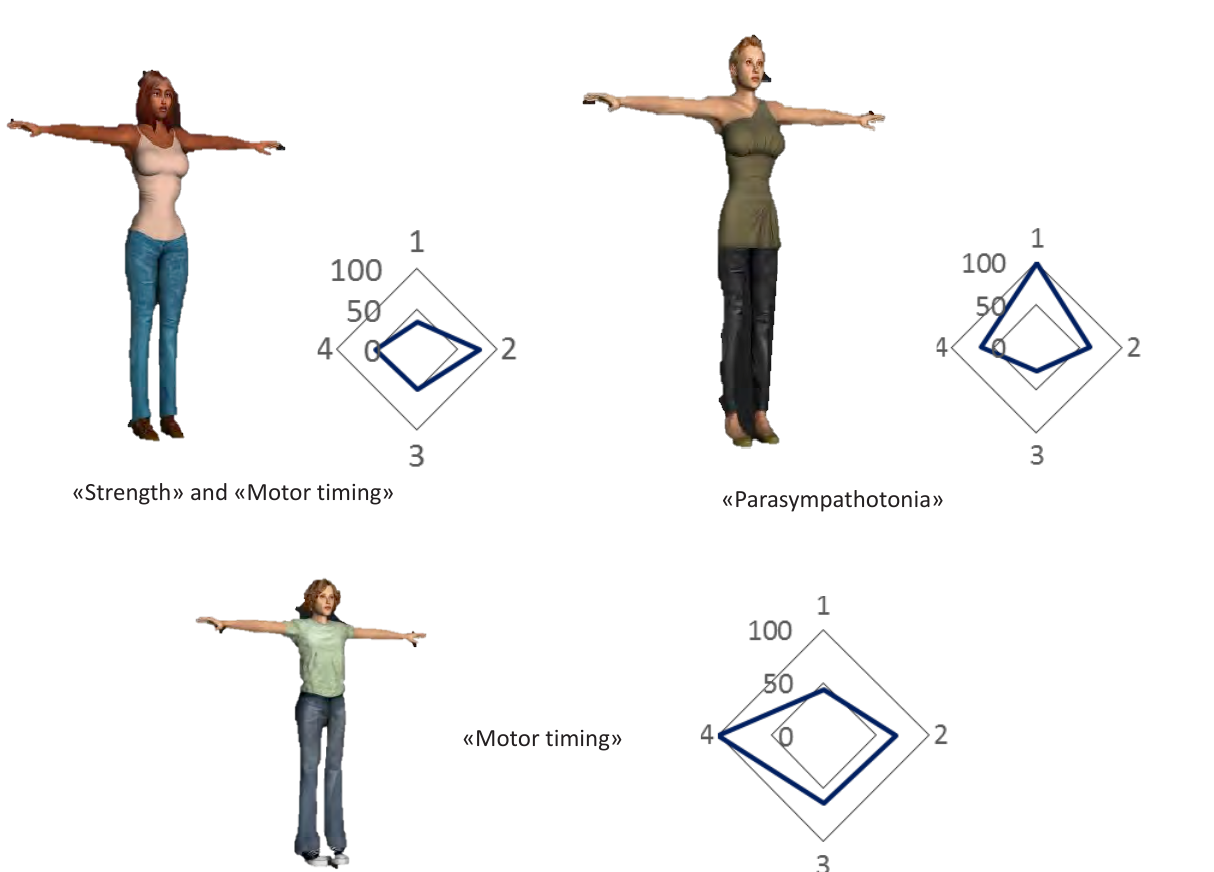
Fig. 3. The examples of individual factorial structure of functional and psycho-physiological opportunities at athletes: results of mathematical and visual 3D-modeling: 1 – Factor «Parasympathicotonia»; 2 – Factor «Strength»; 3 – Factor «Mobility of a nervous system»; 4 – Factor